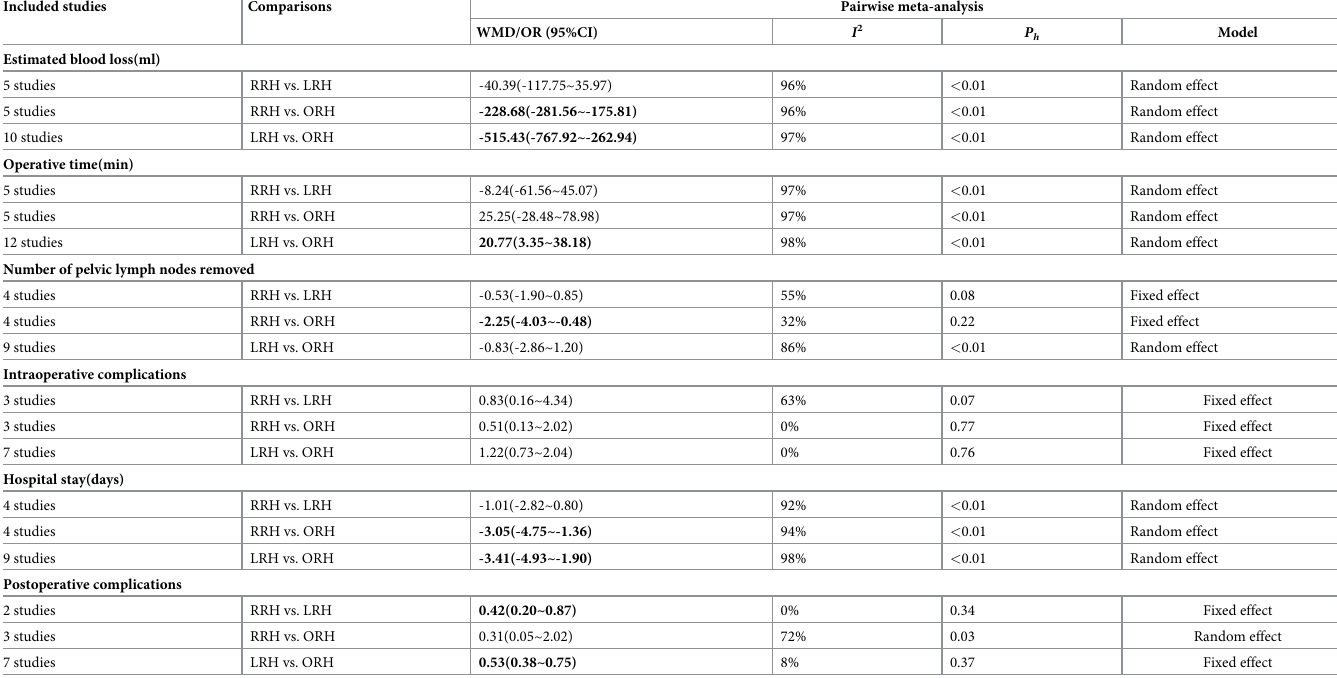
Table 1. Pairwise meta-analysis in terms of six